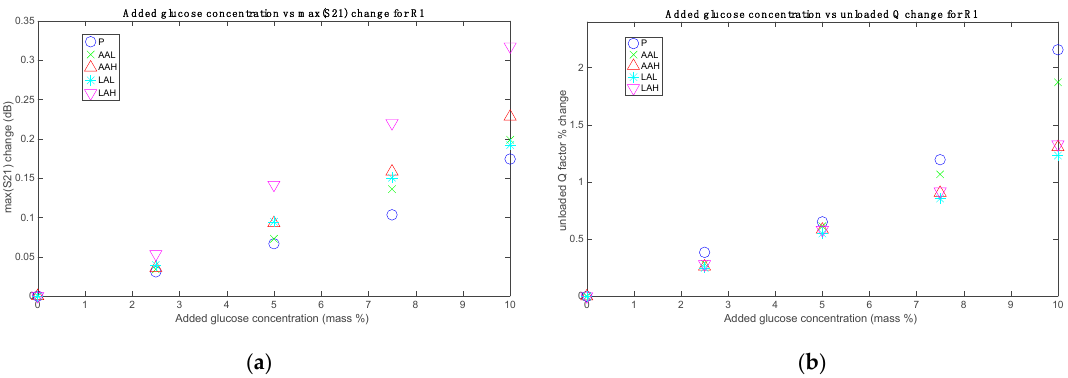
Figure 4. ( a ) Measurements with R1: absolute changes for S21 max ; ( b ) Measurements with R1: percentage changes for the resonator unloaded quality factor Q u .